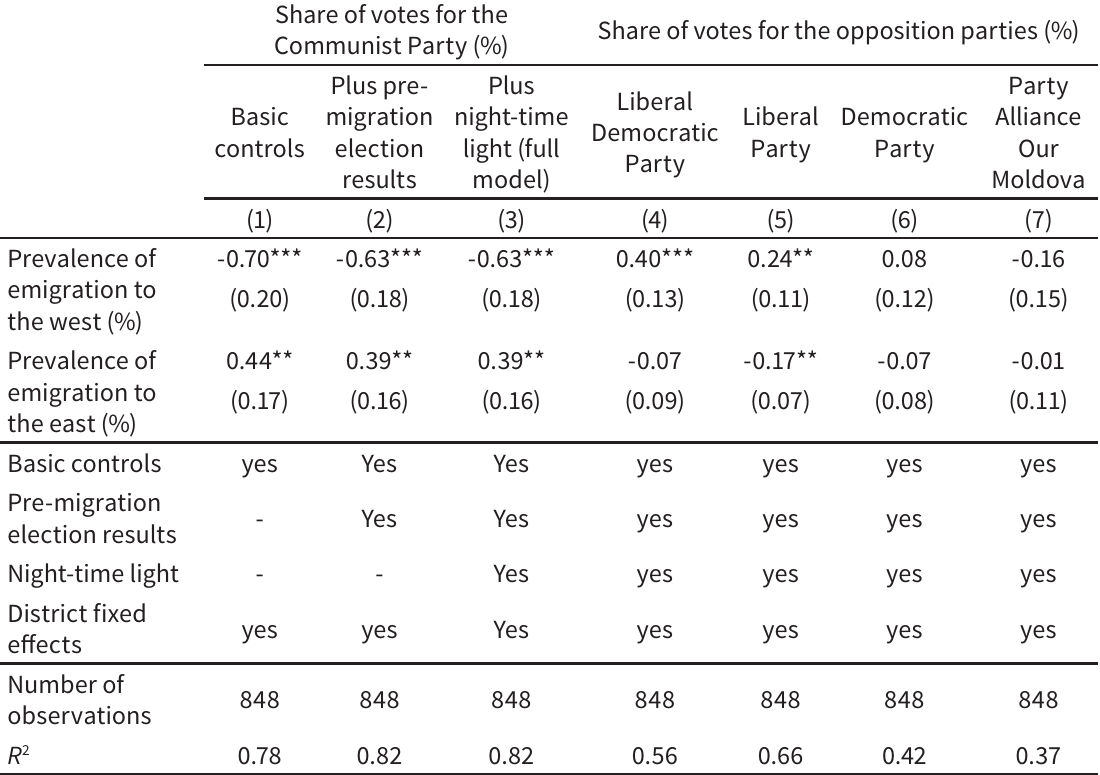
Table 3 East/west migration and general election results in Moldova, July 2009 Share of votes for the Share of votes for the opposition parties Communist Party (%)